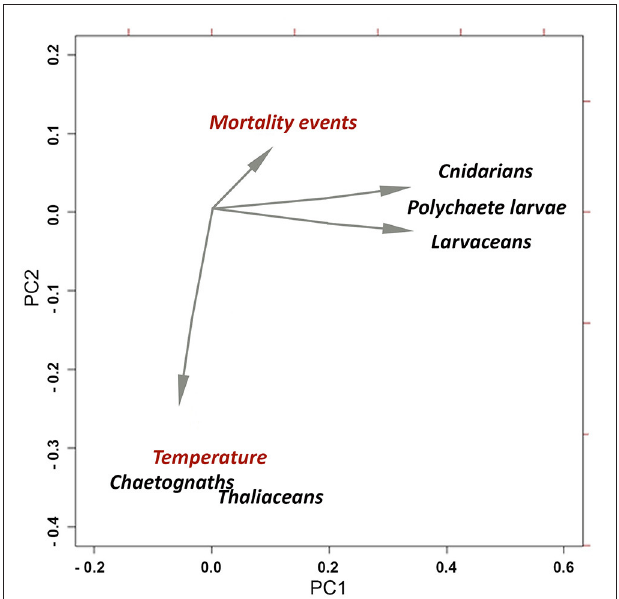
FIGURE 2 | Principal component analysis (PCA) of gelatinous zooplankton (cnidarians, polychaete larvae, larvaceans, chaetognaths, and thaliaceans), fish mortality and temperature in the Almería aquaculture facility.